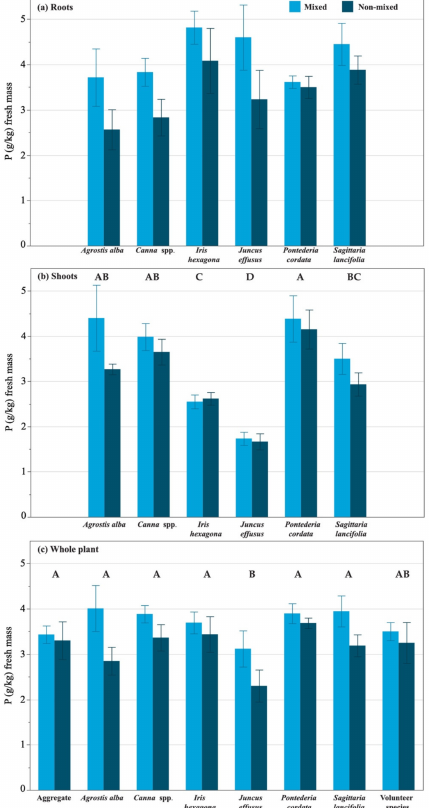
Figure 4. Phosphorus (P) fixed within ( a ) root, ( b ) shoot, and ( c ) whole plant tissues harvested from floating treatment wetlands (with enhanced mixing / no-mixing) after a 1 year deployment (April 2018–April 2019) within the Wickham Park pond in Melbourne, FL, USA. Different letters be- tween species indicate significant differences according to Student’s t post-hoc comparison ( α <